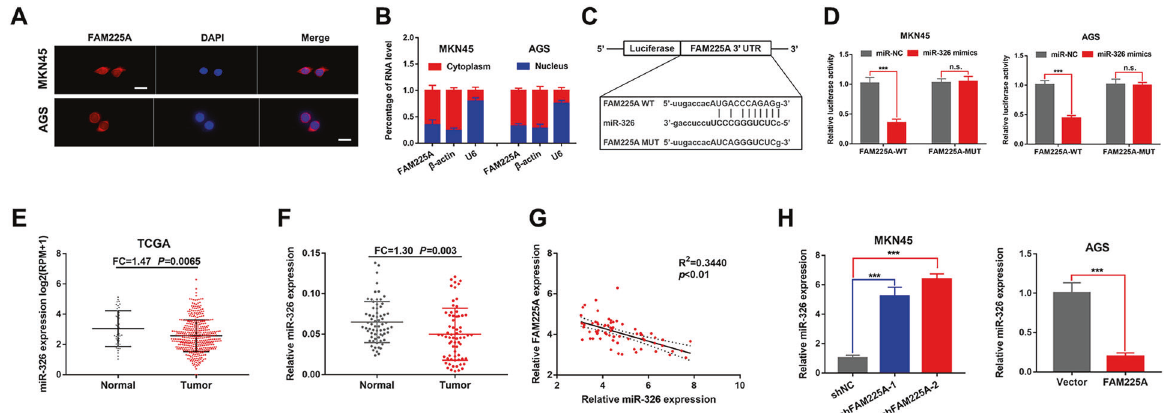
Fig. 4 FAM225A functions as a ceRNA and competitively absorbs miR-326 in GC. A , B FISH and qRT-PCR analysis of the subcellular localization of FAM225A in gastric cancer cells (scale bar: 50 μ m for FISH assay). C , D A dual-luciferase reporter assay suggested that the relative luciferase activity of the wild-type FAM225A was reduced by miR-326. E , F Relative expression of miR-326 in GC tissues according to TCGA database and our own 68 GC tissues. G The correlation between the expression of FAM225A and miR-326 was analyzed in 68 GC tissues. H Detecting miR-326 expression when knockdown or overexpression of FAM225A in MKN45 or AGS cells by using qRT-PCR. p values were obtained by Student ’ s t test. Data are presented as means ± SD. FC fold change, *** p <